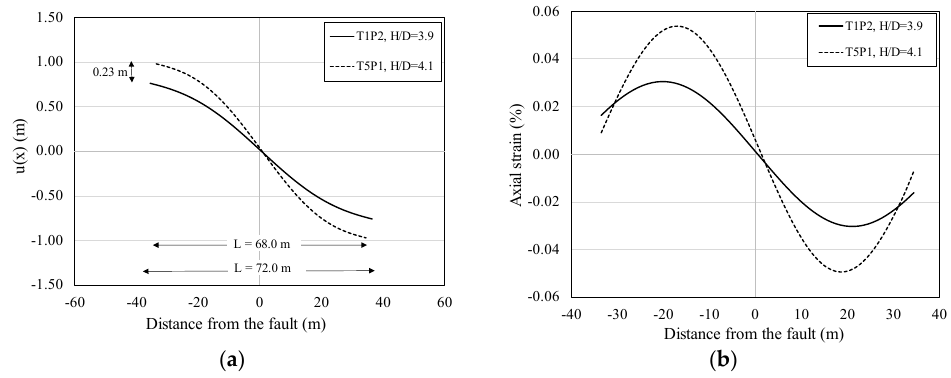
Figure 8. Comparison between the developed analytical model for the trenched pipeline and the analytical model for uniform seabed soil, T1P2 ( W = 1.3 D) and T5P1 ( W = 0.75 D) with ( β = 0 ◦ ): ( a ) deformed pipeline shape, ( b ) distribution of axial strains along the pipeline.